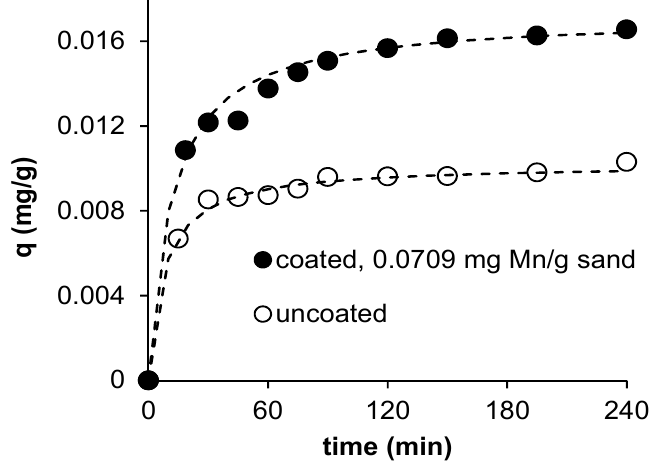
= 50 g, C = 23 mg/L, sand 0